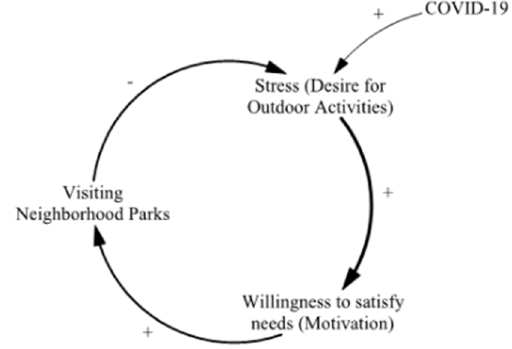
Figure 3. Simple structure of main variables.